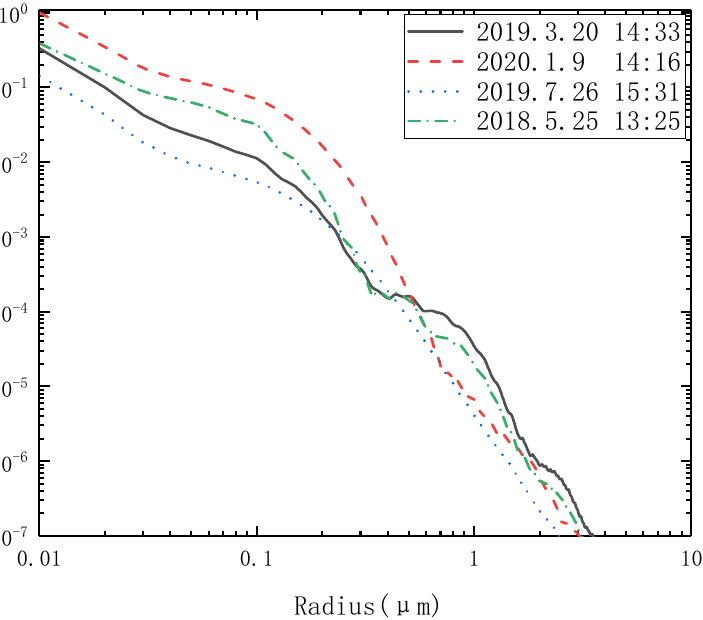
Figure 6. The aerosol PSDs in floating dusty days, blowing dusty days, hazy days and sunny days from the AODs shown in Figure 4 inverted by TSVD regularization algorithm.